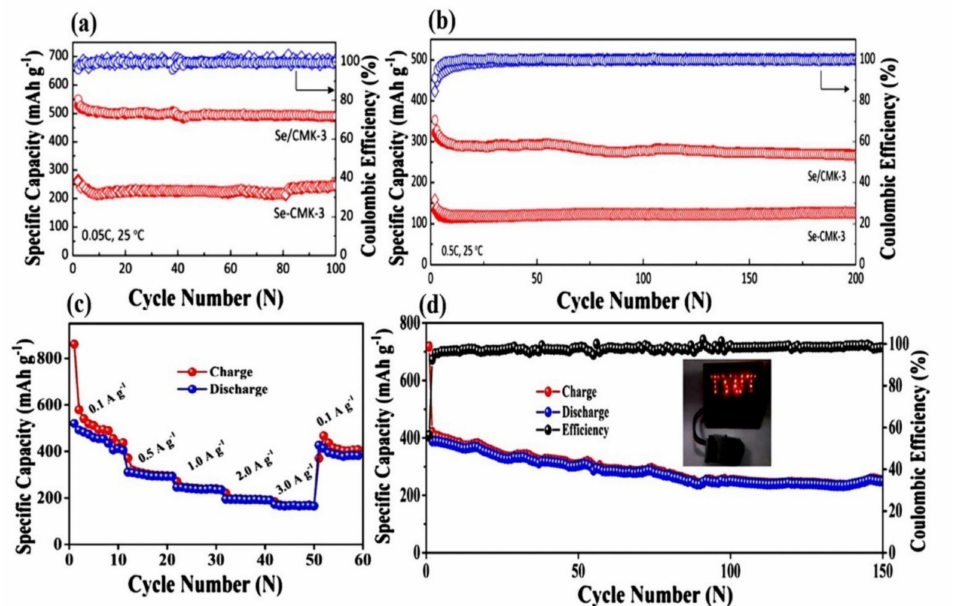
Figure 4. ( a ) Cyclic performances of Se-CMK-3 and Se/CMK-3 at 0.05 C and ( b ) high-rate cyclic performances at 0.5 C. Reproduced with permission from [40], Copyright 2020, American Chemical Society. ( c , d ) Rate performance of Se@HMCS at different rates and cycling performance at 0.5 A g − 1 . Reproduced with permission from [41], Copyright 2020, Elsevier